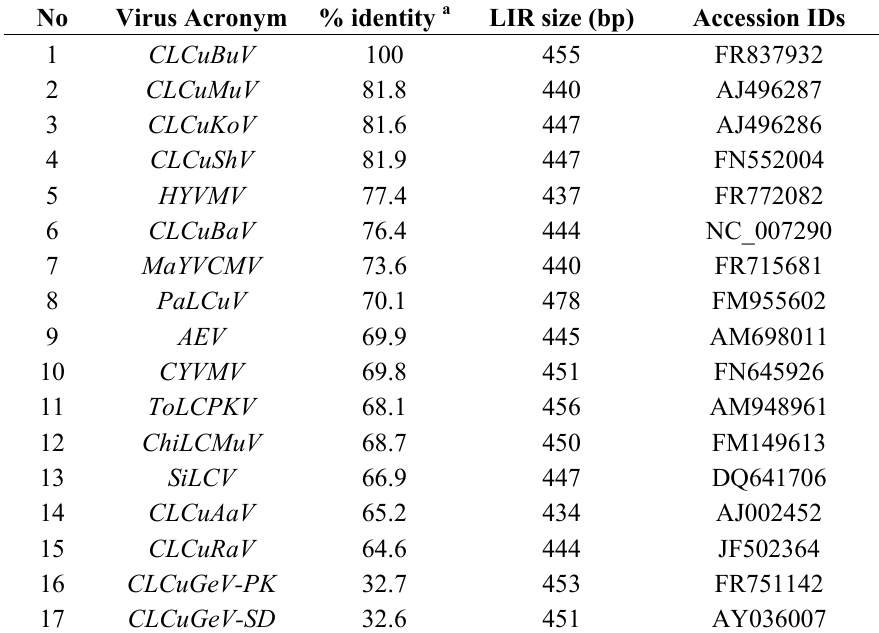
Table 3. Nucleotide sequence comparison of the LIR from CLCuBuV with other closely related geminivirus